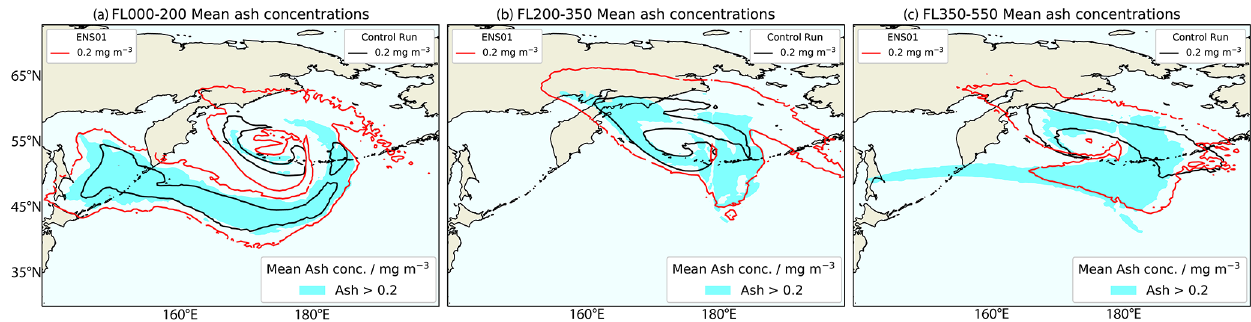
Figure 8. Mean ash concentration values > 0 . 2mgm − 3 for ENS08 members (cyan region) for (a) FL000–200, (b) FL200–350, and (c) FL350–550 at 00:00UTC 24 June 2019. Each panel shows also the associated 0.2mgm − 3 ash concentration contour for both the control run (black contour) and ENS01 (red